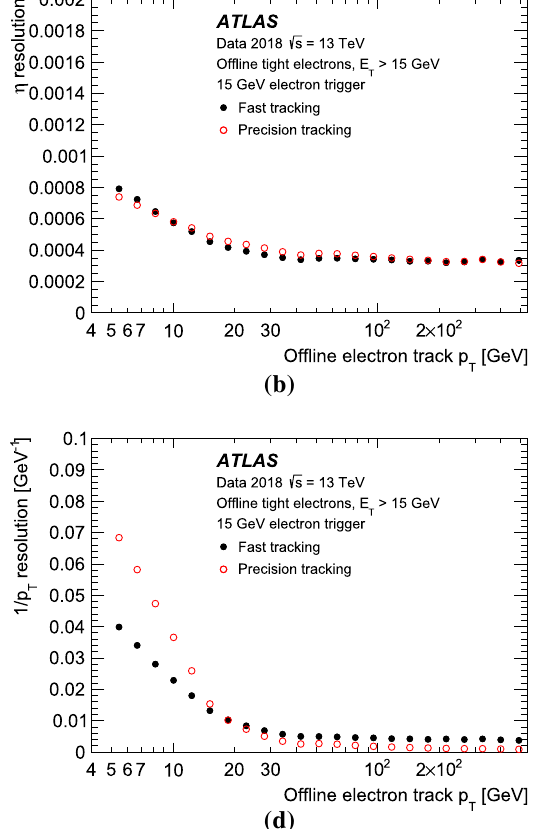
higher p T than for the offline track, and so closer to the trans- verse energy of the electron candidate as determined by the cluster measured in the